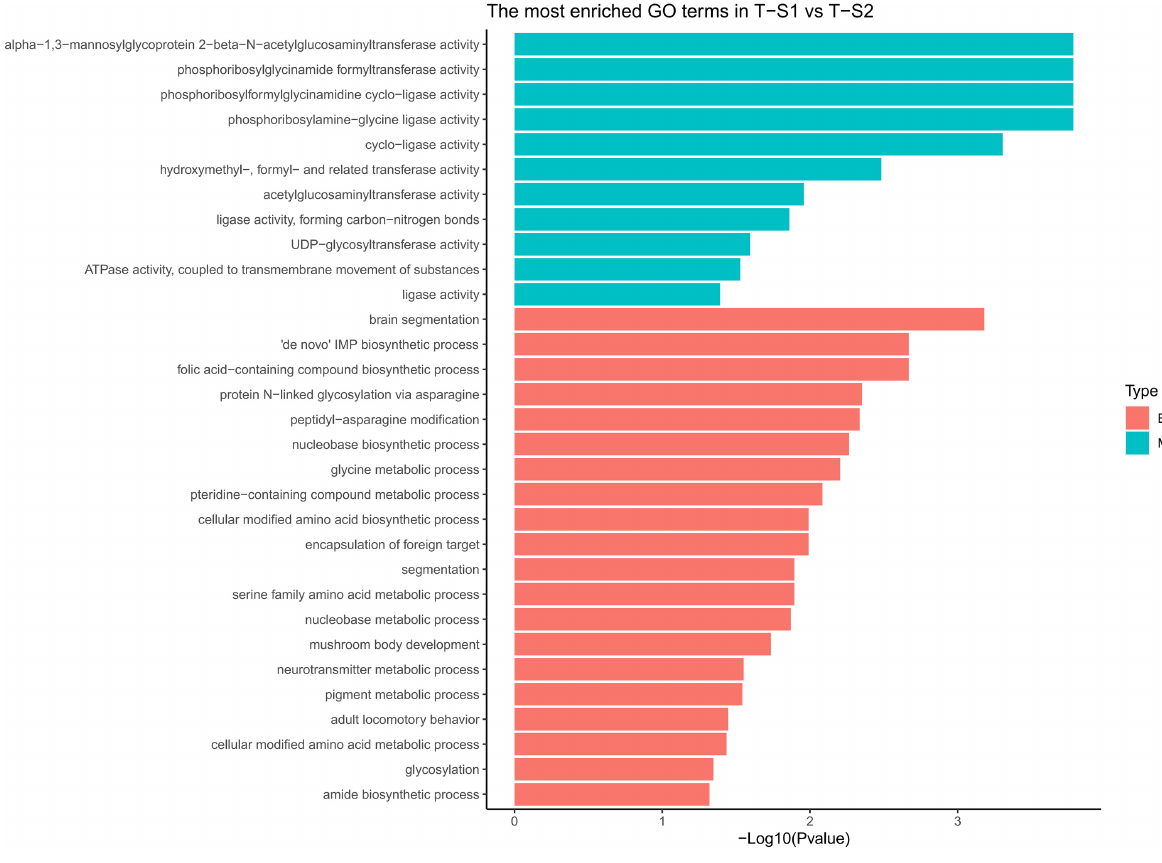
T-S1 (1 Month at 8 m Depth) vs. T-S3 (1 Month at 8 m, 1 Month at 30 m, and 1 Month Back at 8